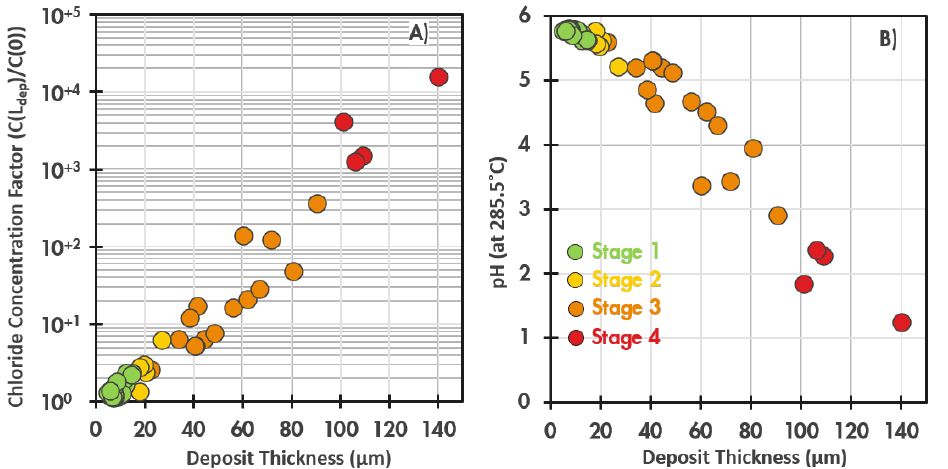
Figure 5. ( A ) Calculated concentration factor and ( B ) pH beneath the porous deposits as a function of the deposit thickness, for a boiler operating under an All Volatile Treatment regime at ~75 bar, with a bulk pH of 9.4 and bulk chloride concentration of ~120 ppb, Stage 4 indicates the onset of rapid UDC [19]. Note: the neutral pH at 286 °C is 5.7.